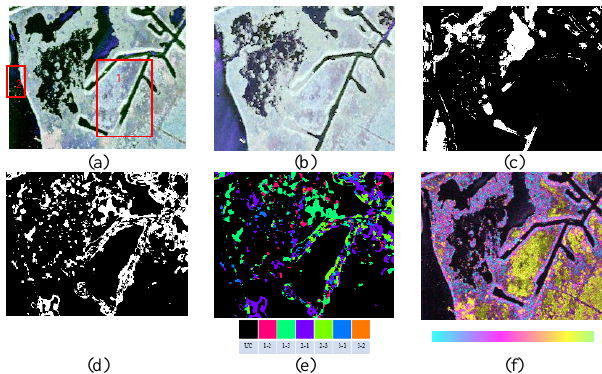
Figure 4. Detail assessment based on the Pauli-RGB images of the red region in figure 3 (Louisiana wetland) after preprocessing, for (a) Jun.17, 2009; (b) Sep.2, 2009; The results of binary change detection map based on PolSAR: (c) TSKI, (d) PCC; (e) The result of land-cover change based on PCC; (f) The coherence map of